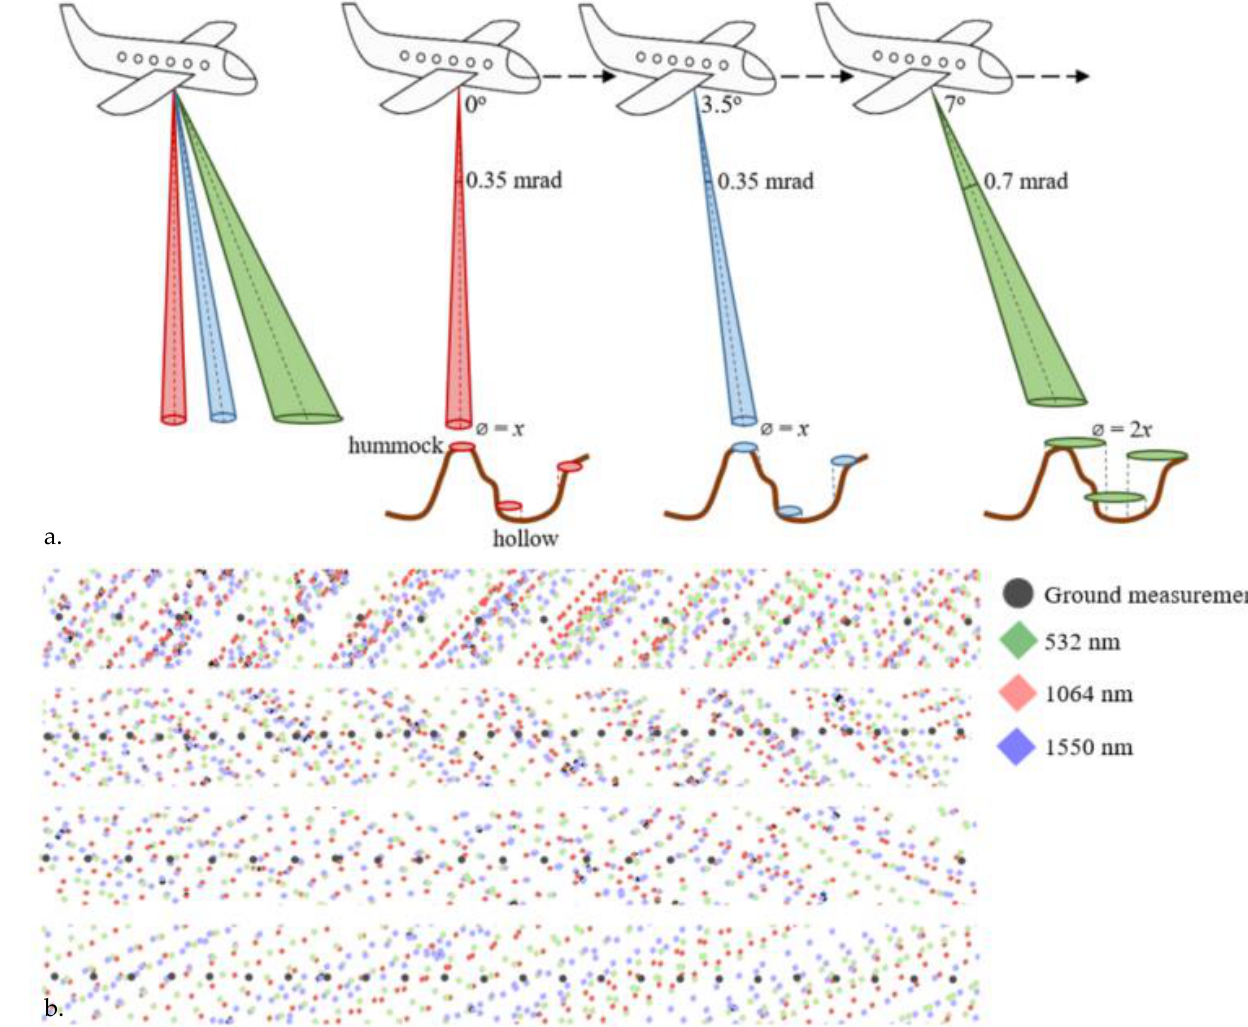
Figure 3. ( a ) Illustration of lidar laser beam angles, beam divergence, and impact on footprint diameter (Ø) in peatlands with variable microtopography (hollows and hummocks); ( b ) Samples of validation transects and lidar data demonstrating spatial distribution of validation points throughout the three channels. Note: microtopography in ( a ) has been exaggerated for demonstration purposes.